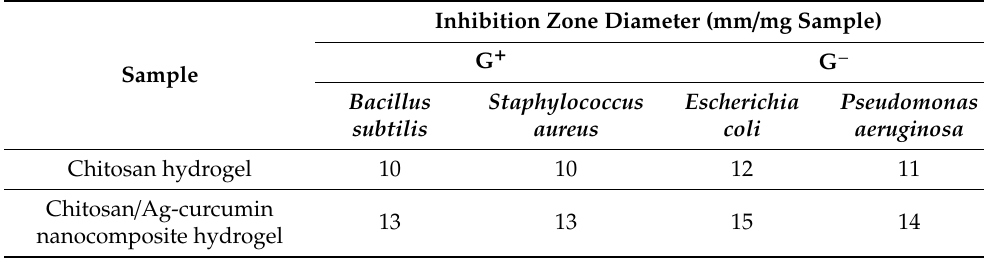
Table1. Theantibacterialactivityofchitosanhydrogelandchitosan / Ag-curcuminnanocompositehydrogel.